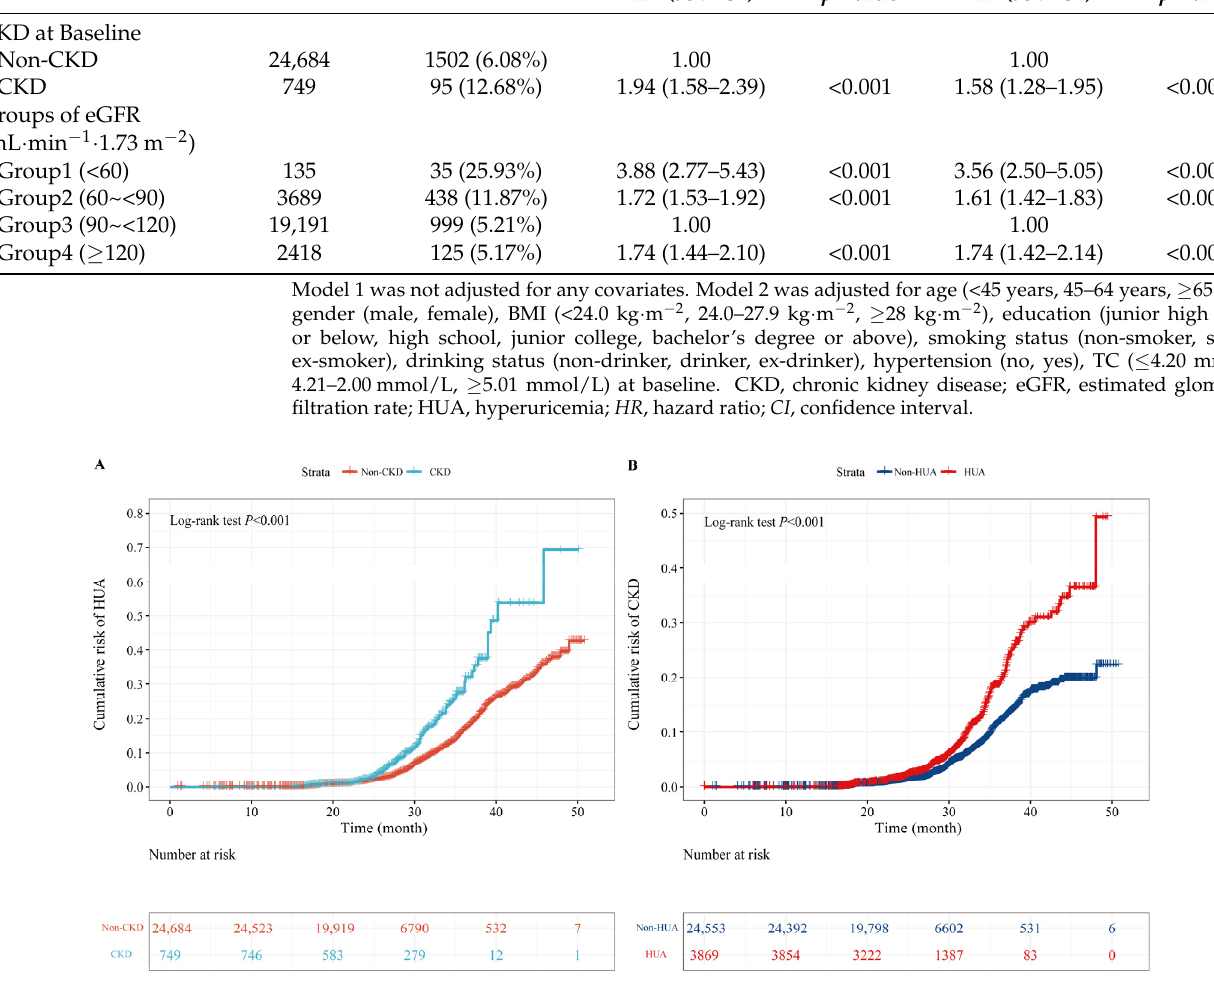
Figure 2. Cumulative incidence of HUA and CKD. (( A ): cumulative incidence of HUA in participants with CKD compared with non-CKD, ( B ): cumulative incidence of CKD in participants with HUA compared with non-HUA). HUA, hyperuricemia; CKD, chronic kidney disease. Table 1. Associations between CKD and eGFR at baseline with new-onset HUA.